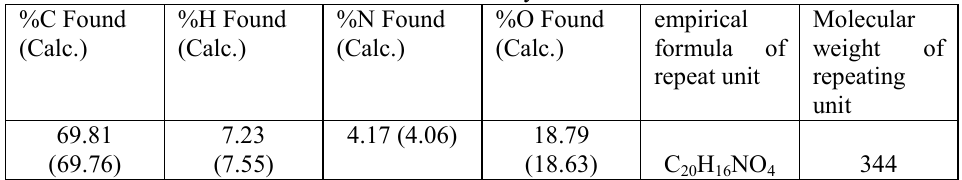
Table 2: Elemental Analysis of